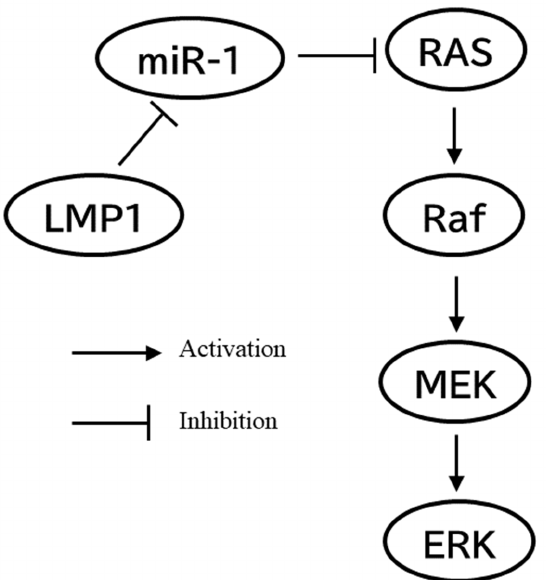
Figure 2. Proposed activation process of RAS pathway by EBV oncoprotein LMP1. RAS is not a downstream effector of LMP1; however, they are indirectly associated. LMP1 activated downstream effector of RAS, Raf-MEK-ERK pathway. Additionally, LMP1 activate RAS through inhibition of miR-1.